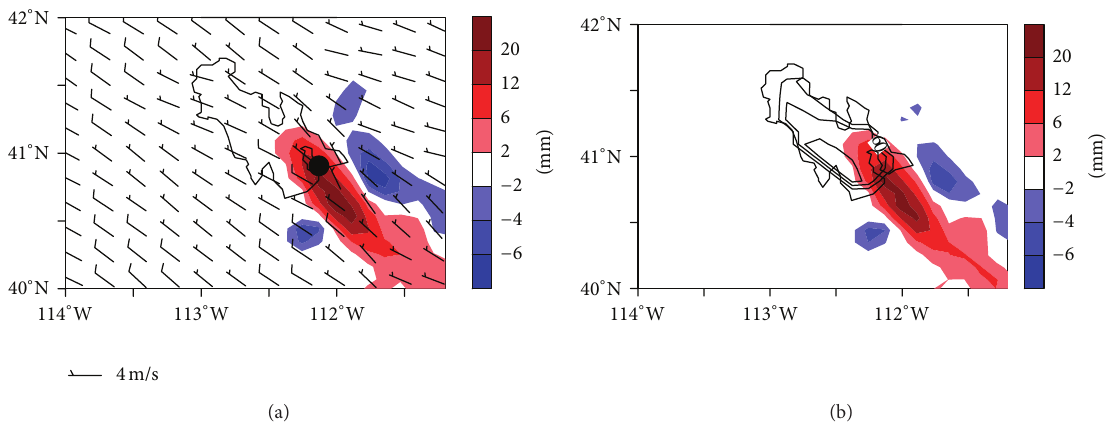
Figure 8: Simulated precipitation difference ((a), (b), shade) between SL and NL (a) and between FL and NL (b), simulated wind filed ((a), barb) in SL experiment and simulated LH ((b), contour) between SL and NL in the first GSL precipitation event.